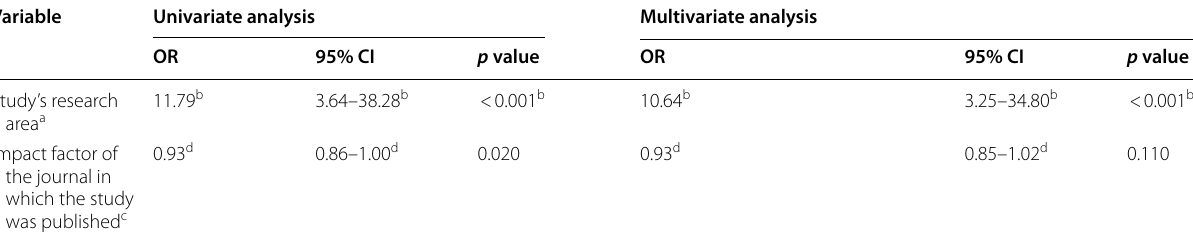
CI: confidence interval, OR: odds ratio a Based on 286 studies with the following primary research areas: artificial intelligence (n (n 4), emergency (n 1), gastrointestinal–abdominal (n = = neuroradiology (n 46), nuclear medicine (n = b Studies with artificial intelligence as research area were significantly associated with increased workload c Based on 26 individual journals with a median impact factor of 5.061 (range: 2.687–33.752)